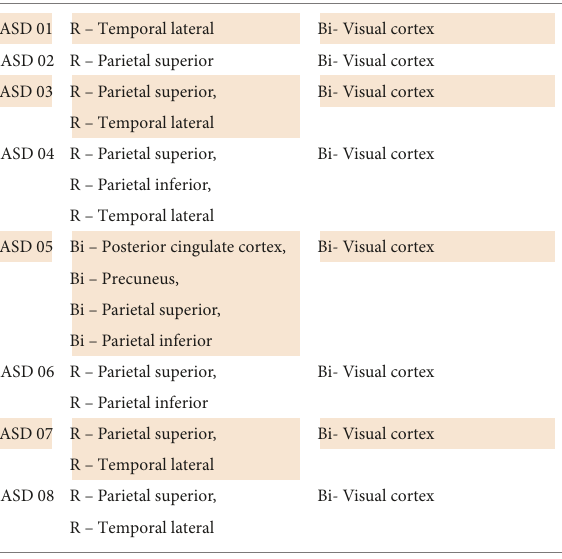
in the right cerebral hemisphere (8/8), in the ROIs examined by visual analysis in all eight ASD participants ( Figure 1 and Table 2 ). Normal brain glucose metabolism was reported by reviewers in all ROIs of the control group.